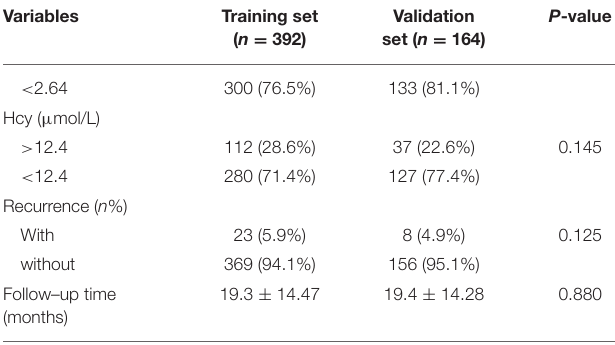
TABLE 2 | Univariate and multivariate Cox analysis of the training